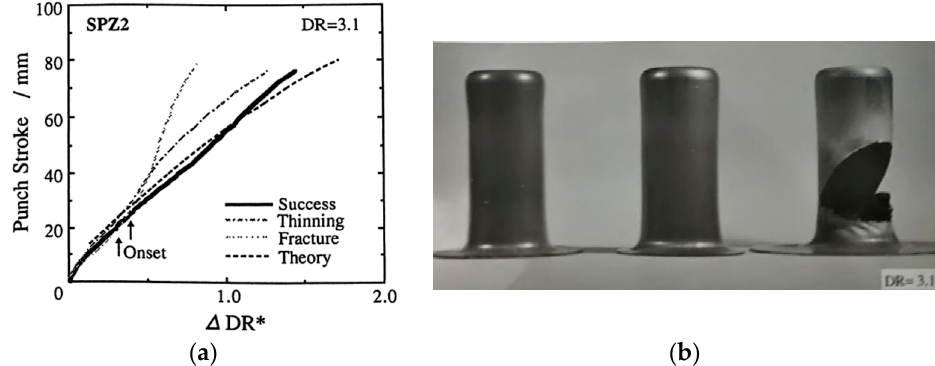
Figure 8. Determination method of the onset point of failure modes in warm superplastic deep drawing and the typical samples of drawn cups (DR = 3.1). ( a ) Punch stroke - Δ DR* diagram, ( b ) failure modes of drawn cup samples. Left: thinning. Center: success (100 mm/min, 0.5 kN). Right: fracture.